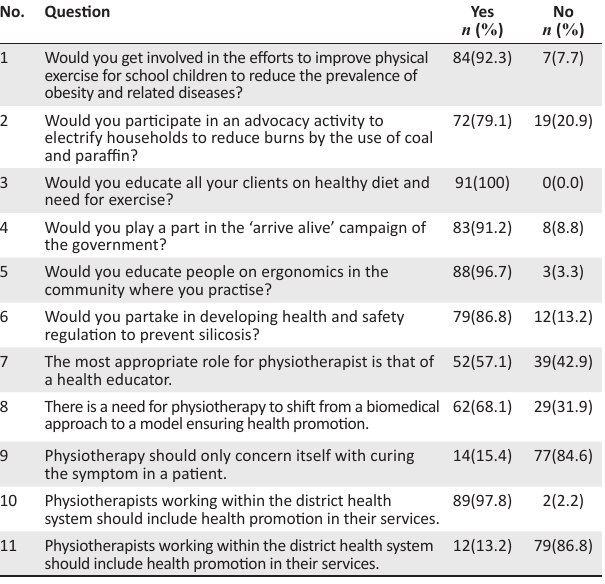
TABLE 3: Physiotherapists’ attitude to health promotion.